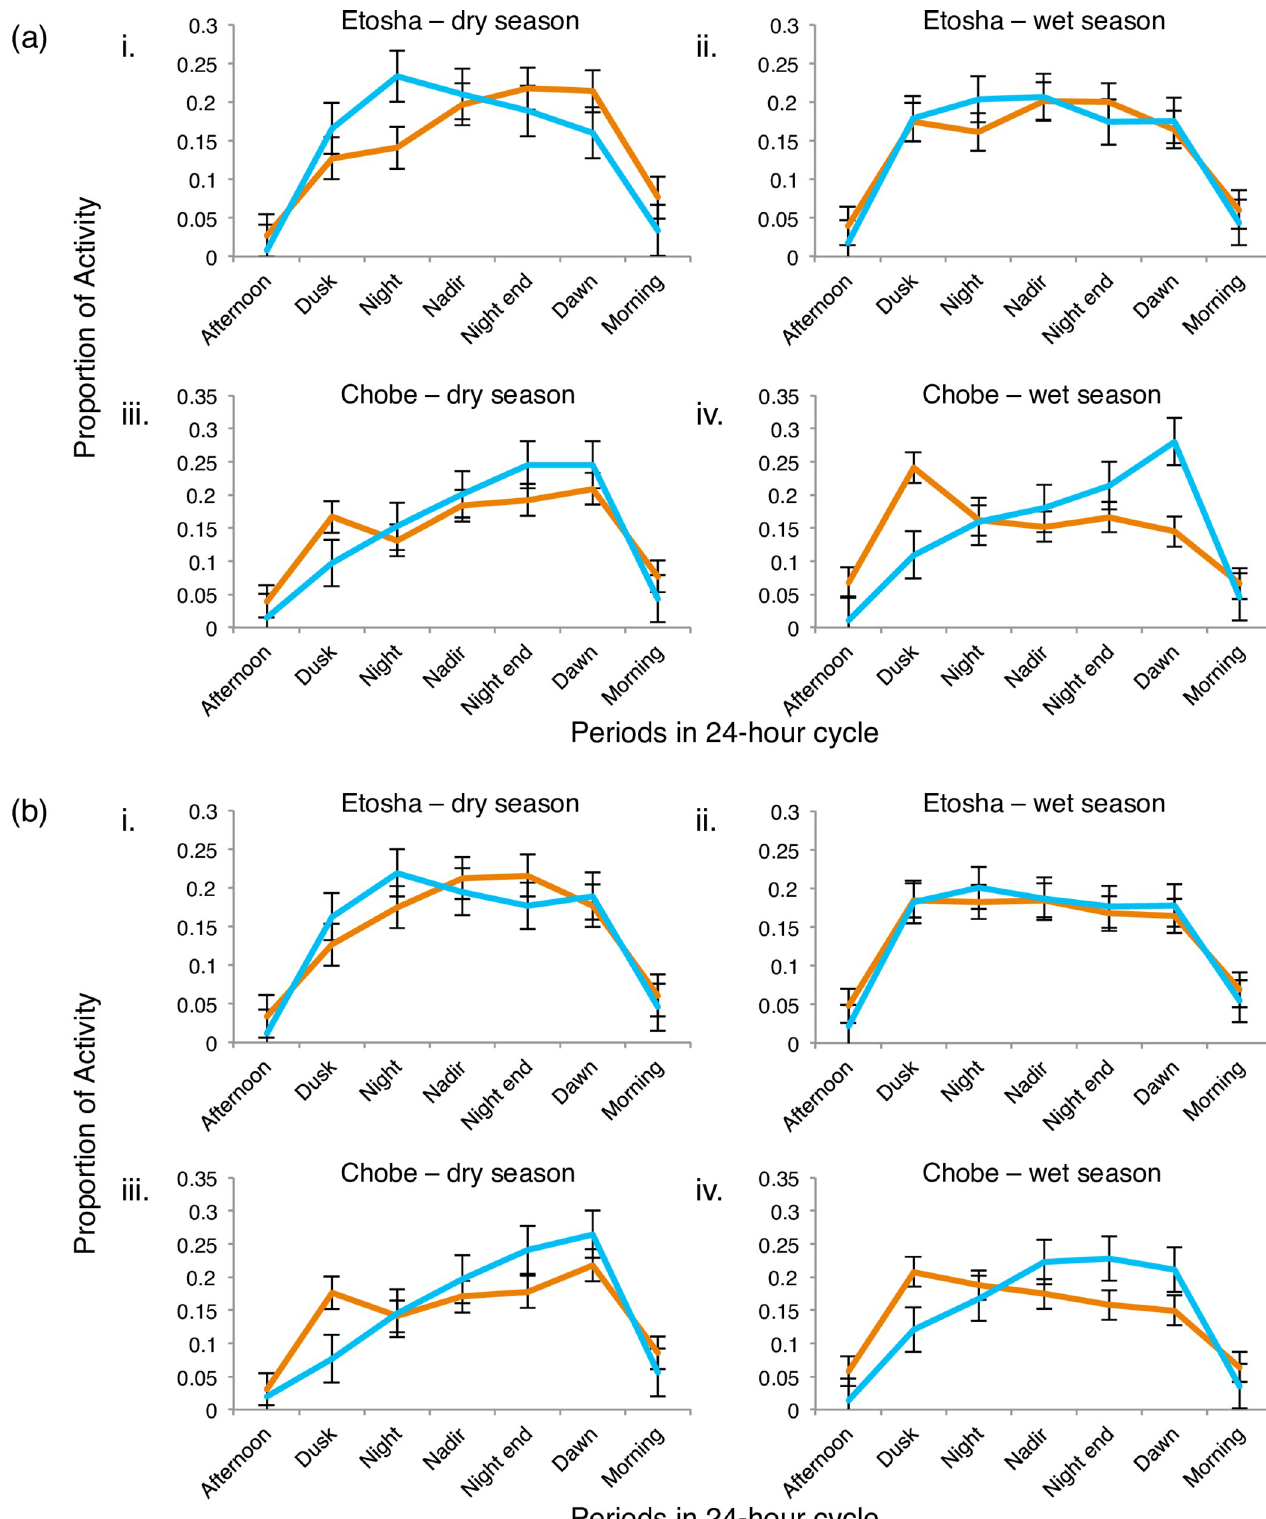
Fig 6. Seasonal activity of lions and spotted hyenas according to full and new moons. Plots portraying the proportion of activity of lions (orange lines) and spotted hyenas (blue lines) during full moon (a) and new moon (b) phases for each of the dry and wet seasons in Etosha and Chobe/Linyanti study areas. The